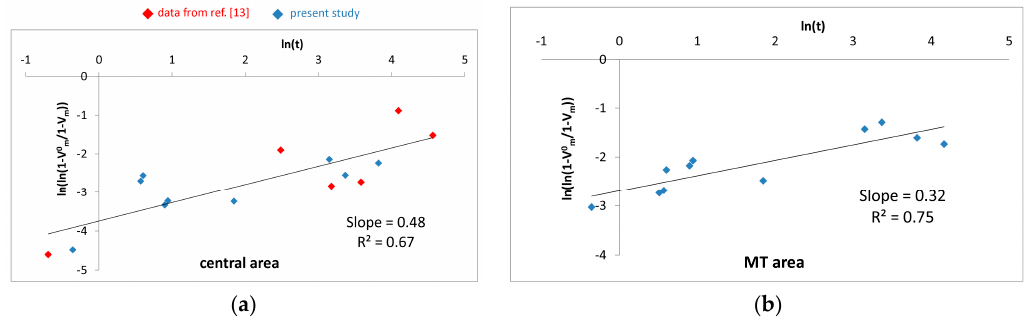
Figure 8. Plot of ln(ln(1 − V 0 m /1 − V m )) versus ln( t ), where t is the follow-up, V 0 m is the average monoclinic content obtained from the Raman spectra of the unworn border area of the retrievals, and V m is the average monoclinic content obtained from the Raman analysis ( a ) near the centre of the articulating surface using optical conditions ( a ) in the present study and in a previous one [13], and ( b ) near the MT region using optical conditions ( b ).